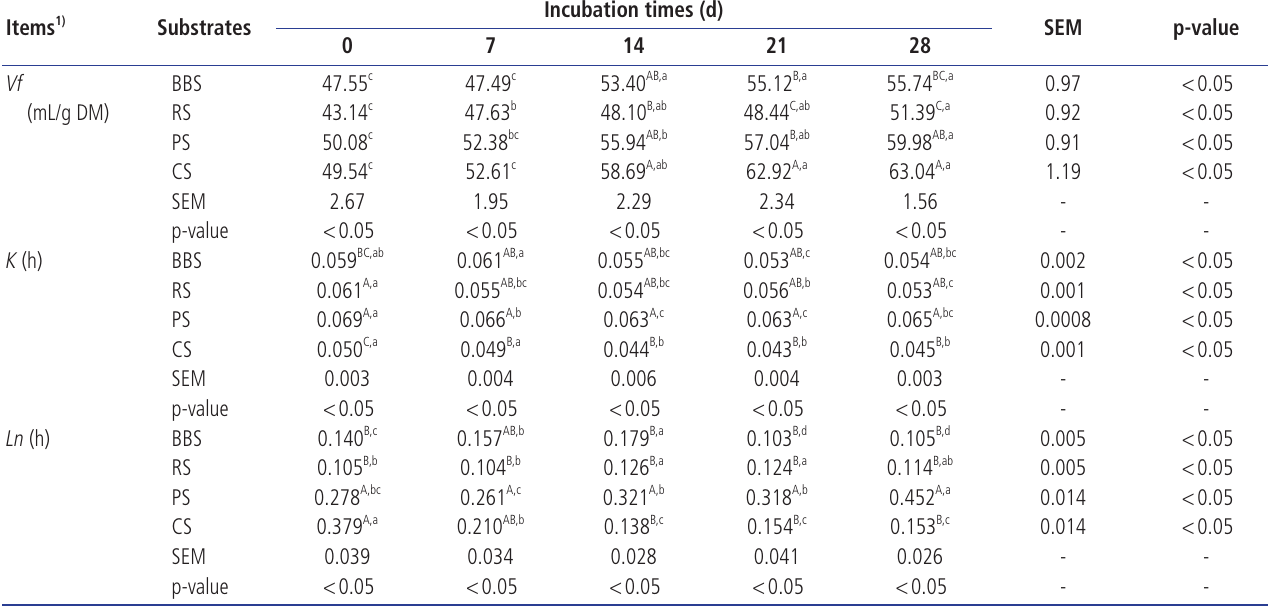
Table 1. Dynamic parameters of gas production for various types of roughage cultured with Pleurotus ostreatus for different incubation times Items 1)